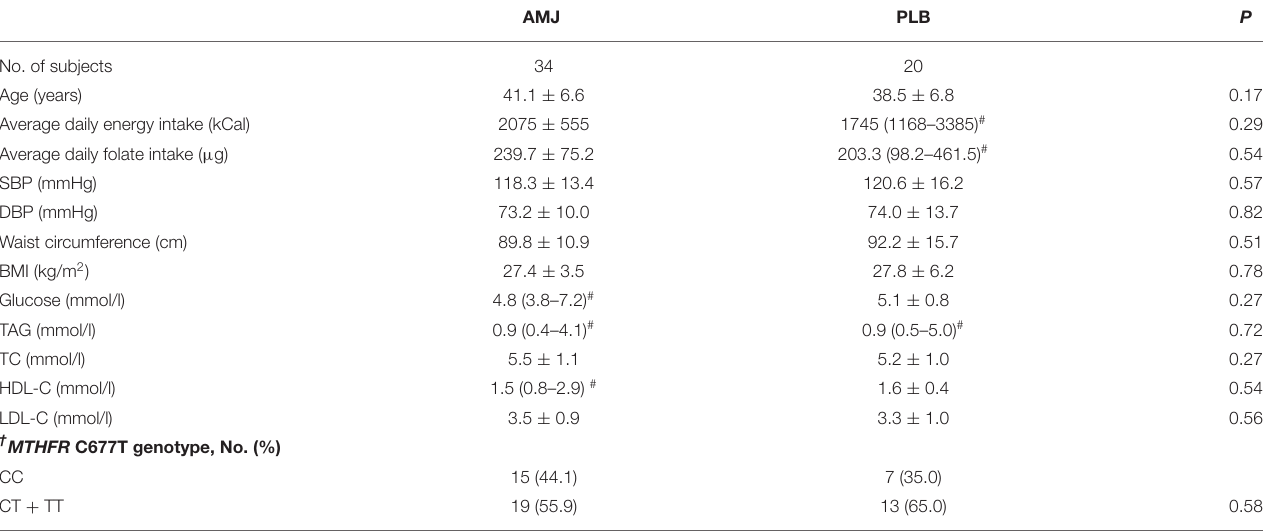
TABLE 1 | Baseline characteristics of the study